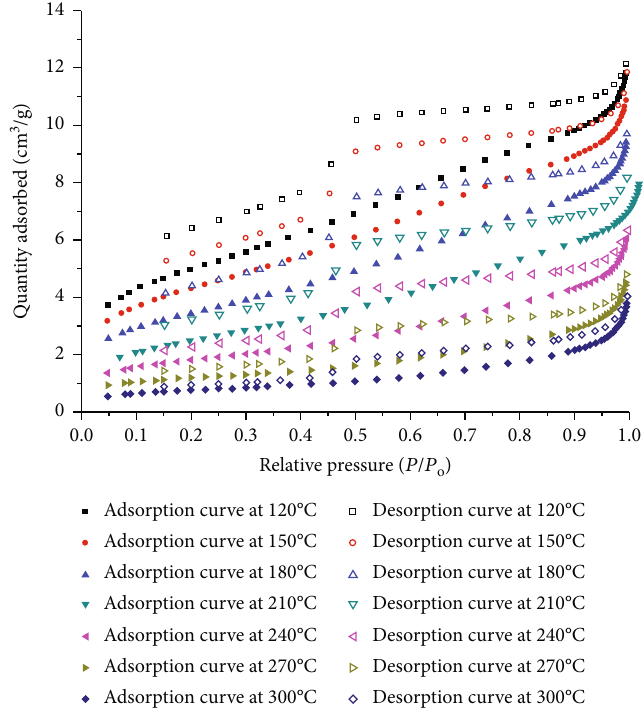
Figure 1: The isothermal adsorption and desorption curves of coal under various pretreatment temperatures.